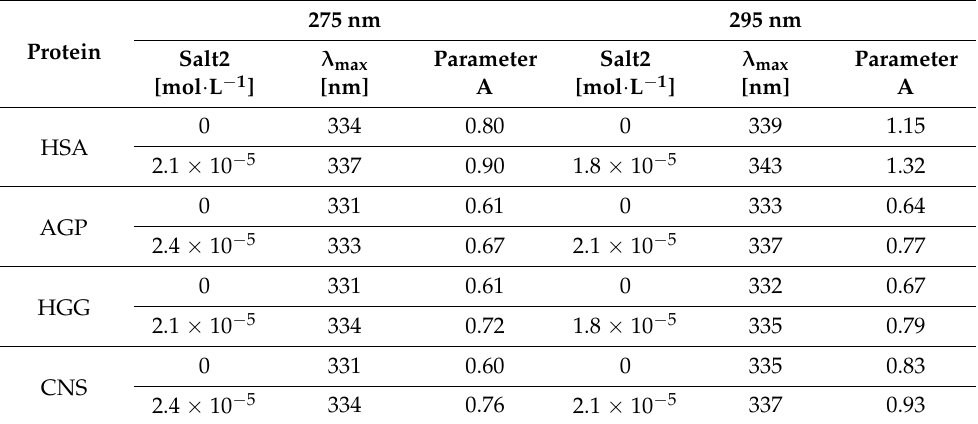
Table 2. Fluorescence parameters of HSA, AGP, HGG and CNS at 3 × 10 − 6 mol · L − 1 concentrations ( λ ex 275 nm and λ ex 295